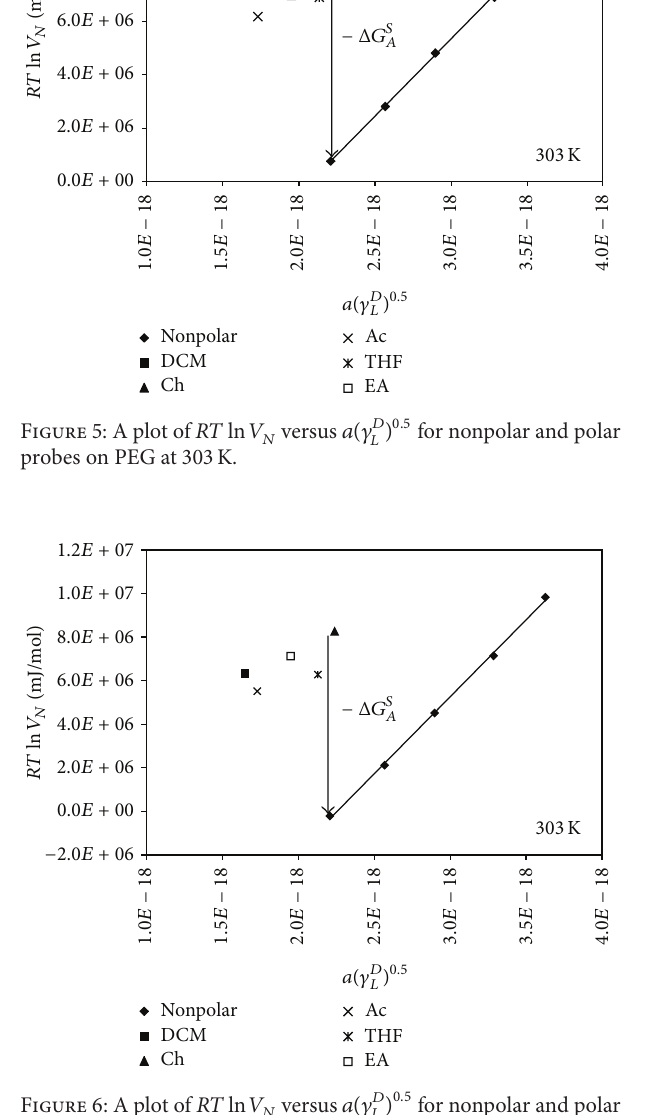
Figure 6: A plot of 𝑅𝑇 ln 𝑉 𝑁 versus 𝑎(𝛾 𝐷 𝐿 ) 0.5 for nonpolar and polar probes on PEG-Tos at 303 K.